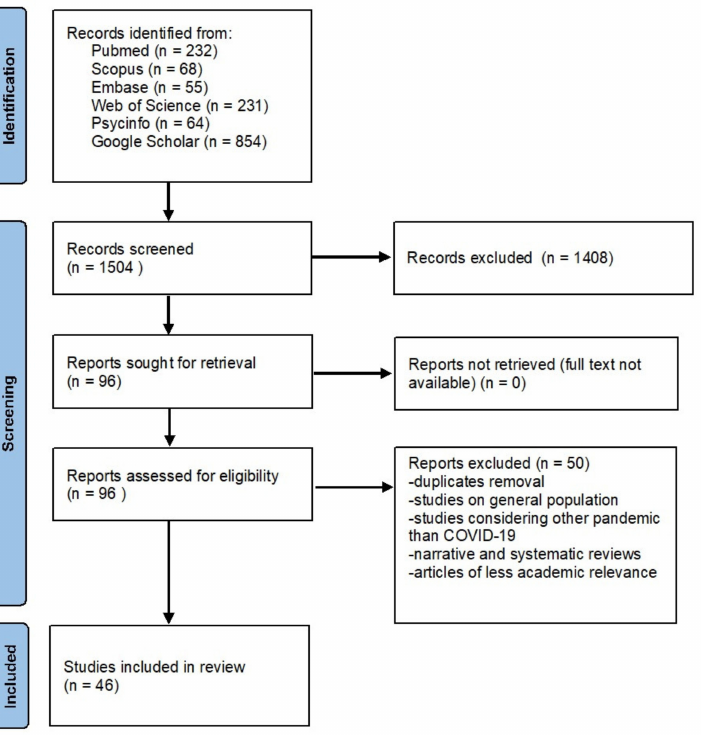
Figure 1. Flow diagram of the literature search and articles selection (adapted from PRISMA 2020 guidelines for systematic reviews)